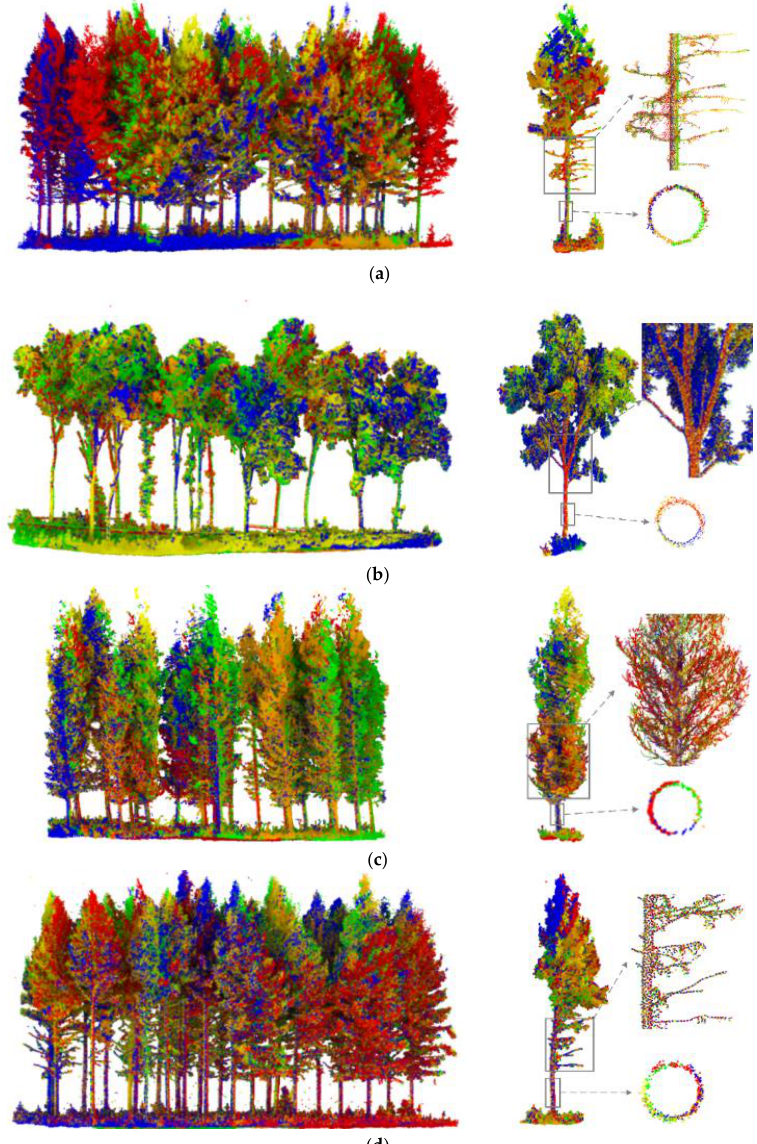
Figure 6. Global adjustment results. Different colors represent different TLS point clouds. ( a – d ) represent the adjustment results of the TLS point clouds in Datasets 1, 2, 3, and 4, respectively.